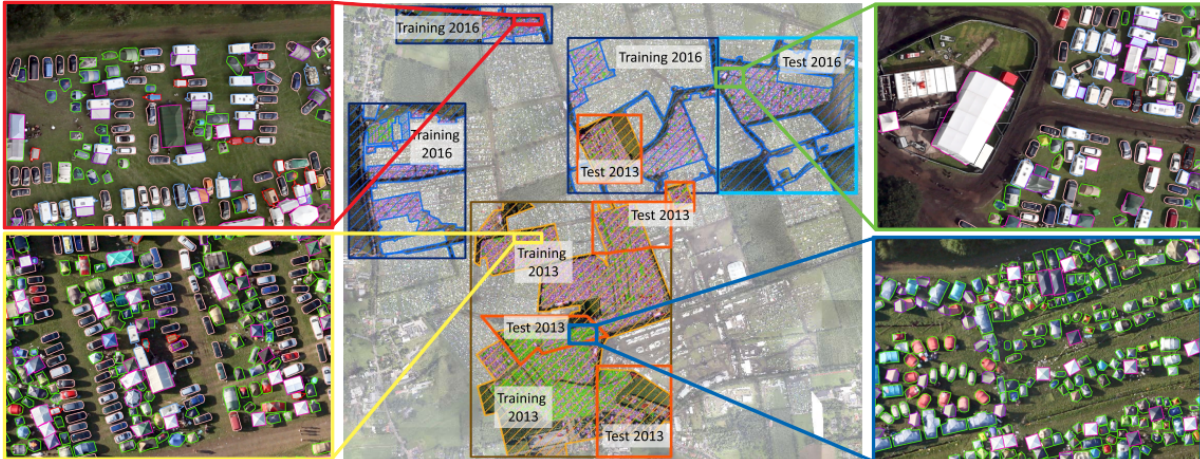
Figure 2. Illustration of the DLR-AerialTent dataset with overlaid annotations for 10 semantic classes including different types of tents, vehicles and infrastructure elements. The images were acquired during a music festival in Germany. The Ground Sampling Distance (GSD) of the images is 9cm/px and 10cm/px respectively. The image in the center shows the festival area and the selected training and test areas of the 2013 and 2016 datasets. Color codes: (cid:4)(cid:4)(cid:4)(cid:4)(cid:4)(cid:4)(cid:4)(cid:4)(cid:4)(cid:4)(cid:4)(cid:4)(cid:4)(cid:4)(cid:4)(cid:4)(cid:4) tent: sleep function, (cid:4)(cid:4)(cid:4)(cid:4)(cid:4)(cid:4)(cid:4)(cid:4)(cid:4)(cid:4)(cid:4)(cid:4)(cid:4)(cid:4)(cid:4)(cid:4)(cid:4) small vehicle/transporter, (cid:4)(cid:4)(cid:4)(cid:4)(cid:4)(cid:4)(cid:4)(cid:4)(cid:4)(cid:4)(cid:4)(cid:4)(cid:4)(cid:4)(cid:4)(cid:4)(cid:4) trailer, (cid:4)(cid:4)(cid:4)(cid:4)(cid:4)(cid:4)(cid:4)(cid:4)(cid:4)(cid:4)(cid:4)(cid:4)(cid:4)(cid:4)(cid:4)(cid:4)(cid:4) truck/bus, (cid:4)(cid:4)(cid:4)(cid:4)(cid:4)(cid:4)(cid:4)(cid:4)(cid:4)(cid:4)(cid:4)(cid:4)(cid:4)(cid:4)(cid:4)(cid:4)(cid:4) camper/caravan, (cid:4)(cid:4)(cid:4)(cid:4)(cid:4)(cid:4)(cid:4)(cid:4)(cid:4)(cid:4)(cid:4)(cid:4)(cid:4)(cid:4)(cid:4)(cid:4)(cid:4) pavilion/large tent: assembly and supply function, (cid:4)(cid:4)(cid:4)(cid:4)(cid:4)(cid:4)(cid:4)(cid:4)(cid:4)(cid:4)(cid:4)(cid:4)(cid:4)(cid:4)(cid:4)(cid:4)(cid:4) awning, tarpaulin, (cid:4)(cid:4)(cid:4)(cid:4)(cid:4)(cid:4)(cid:4)(cid:4)(cid:4)(cid:4)(cid:4)(cid:4)(cid:4)(cid:4)(cid:4)(cid:4)(cid:4) inflatable pool, (cid:4)(cid:4)(cid:4)(cid:4)(cid:4)(cid:4)(cid:4)(cid:4)(cid:4)(cid:4)(cid:4)(cid:4)(cid:4)(cid:4)(cid:4)(cid:4)(cid:4) infrastructure, (cid:4)(cid:4)(cid:4)(cid:4)(cid:4)(cid:4)(cid:4)(cid:4)(cid:4)(cid:4)(cid:4)(cid:4)(cid:4)(cid:4)(cid:4)(cid:4)(cid:4) other objects